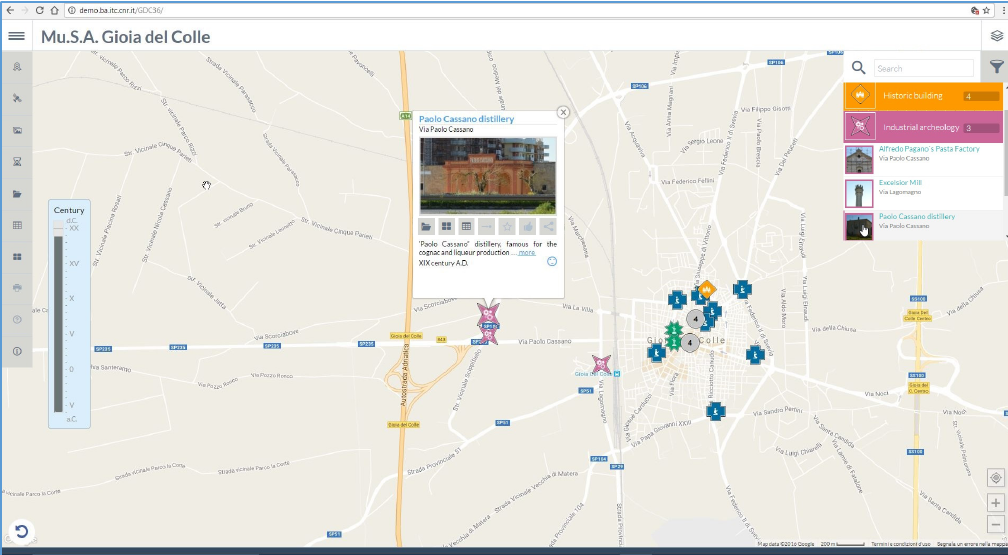
Figure 4. The interactive map of “Gioia del Colle”; the map displays all PoIs because the “Time slider” (on the left, detached from the frame) is set on the XX Century. The main components of our interactive map are: “Menu” ( left ); “Callout” ( centre ); and “Sidebar” ( right ).